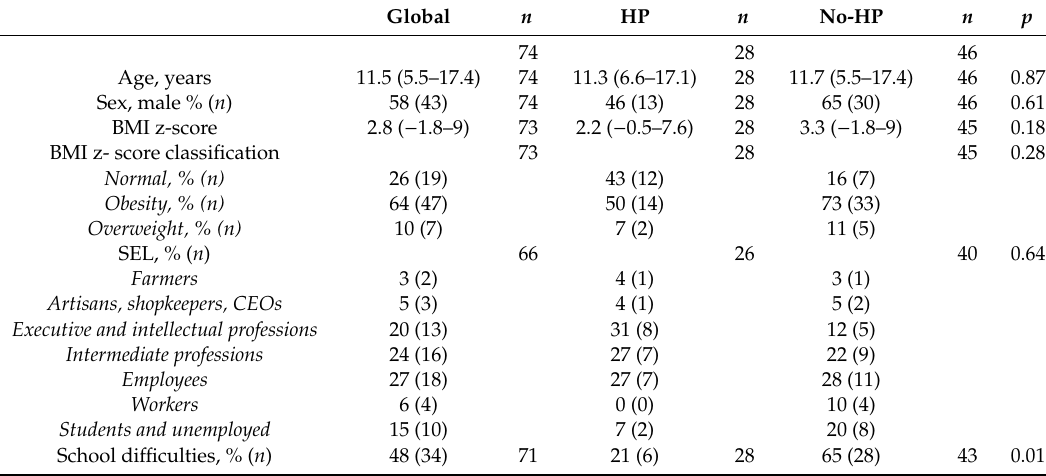
Table 1. Demographic characteristics of children with and without high potential (HP).